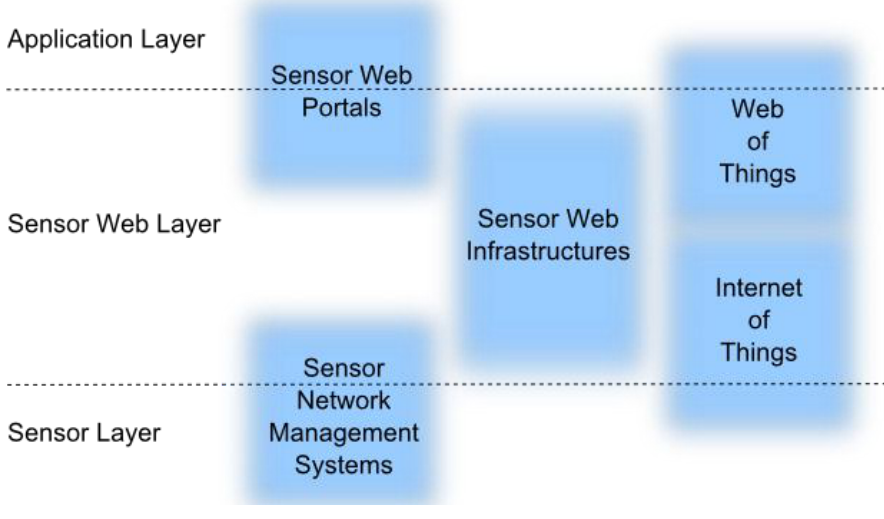
Figure 1. The Sensor Web layer stack and located middleware